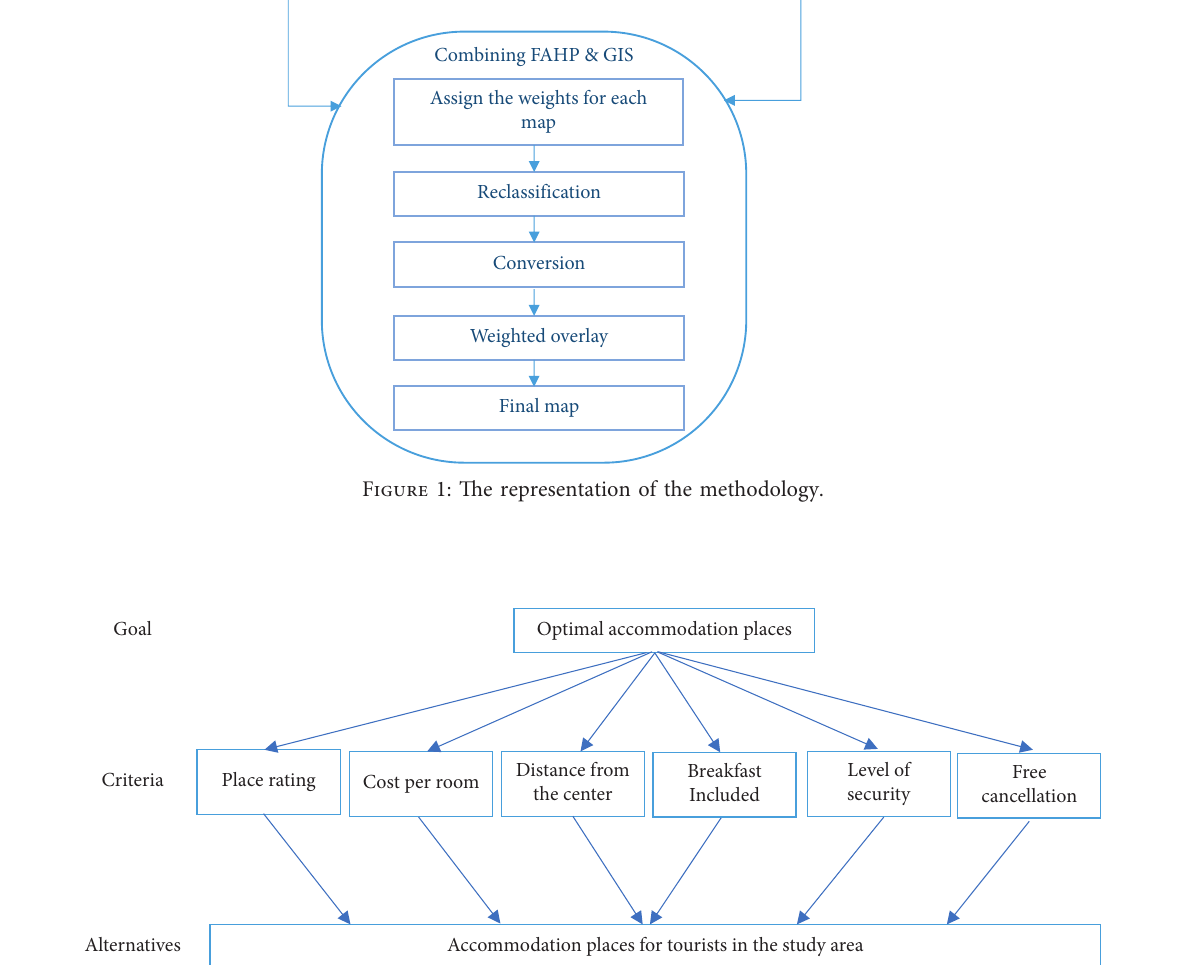
Figure 2: The hierarchical structure of the method to find a place of